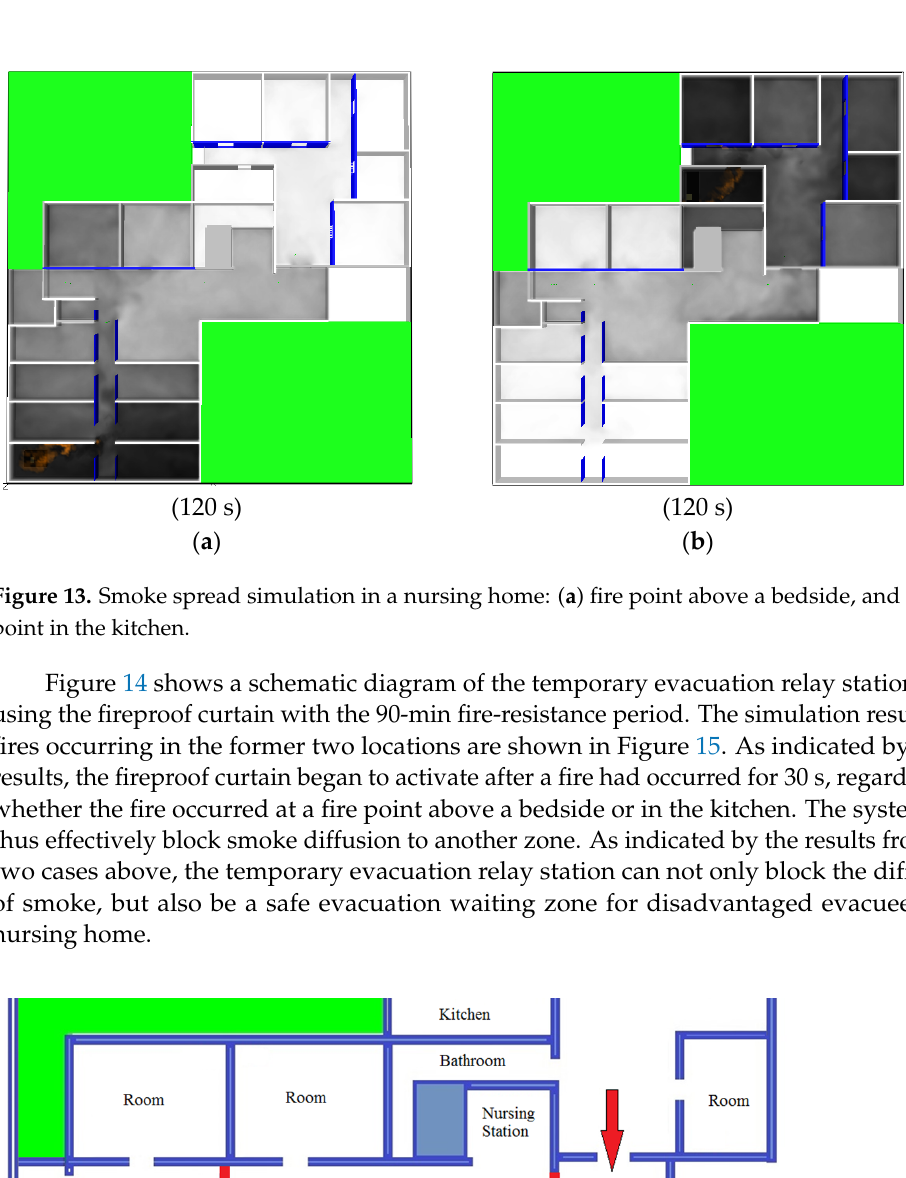
Figure 13. Smoke spread simulation in a nursing home: ( a ) fire point above a bedside, and ( b ) fire point in the kitchen.